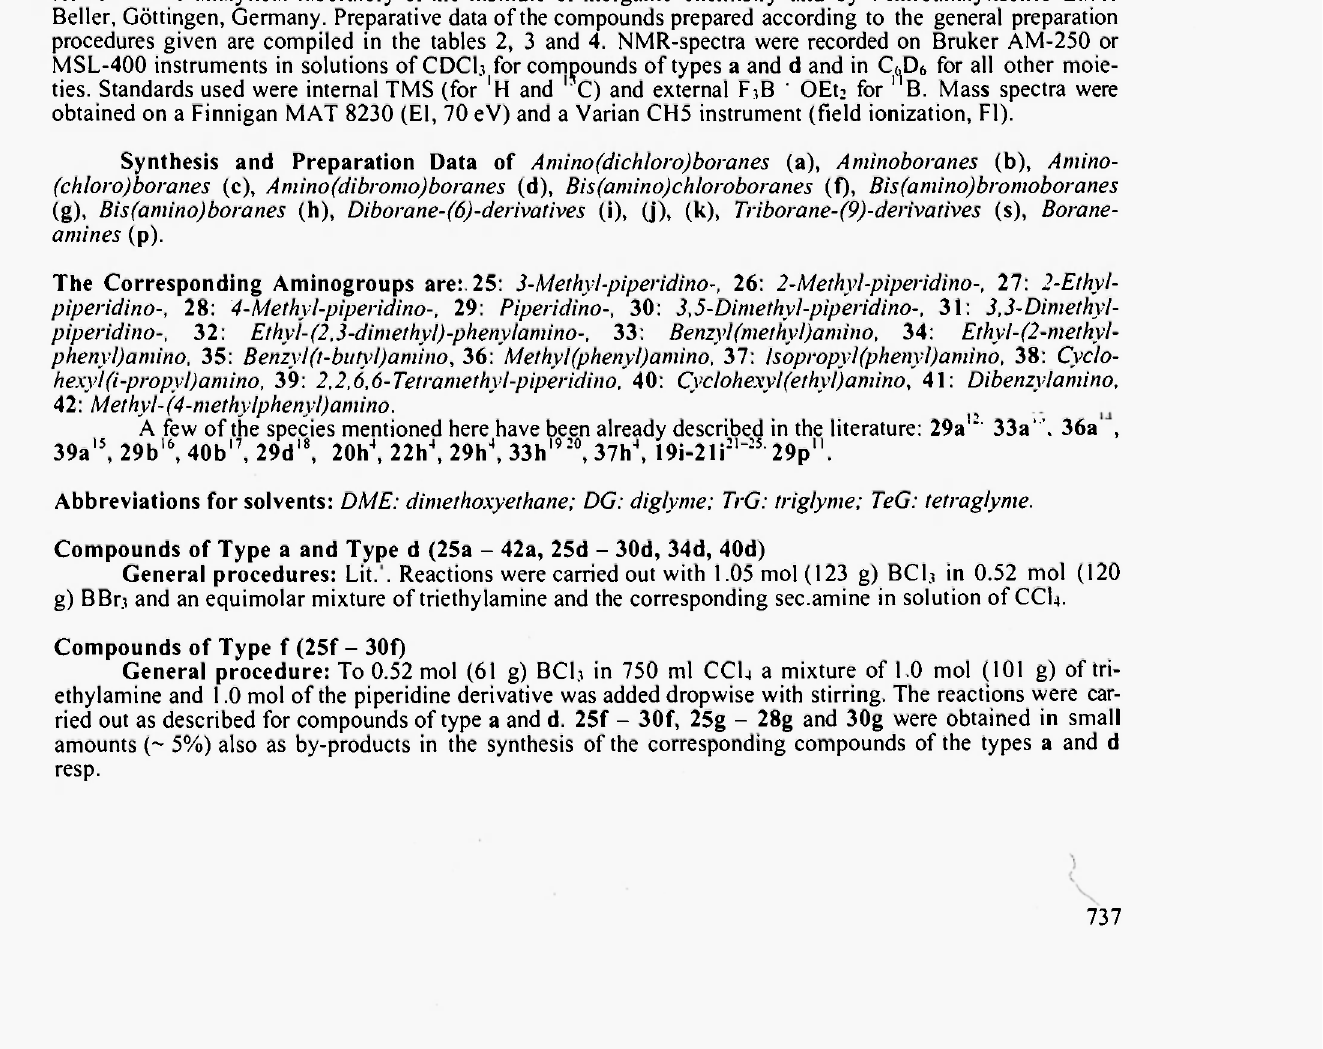
Figure 1. Crystal structure of 26b with anisotropic displacement parameters depicting 50% probability. Selected Bond lengths [A] and angles [°]: B(l)-N(l) 1.606(2), B(l)-N(l)#l 1,598(2), N(l)-C(2) 1.488(2), N(l)-C(6)